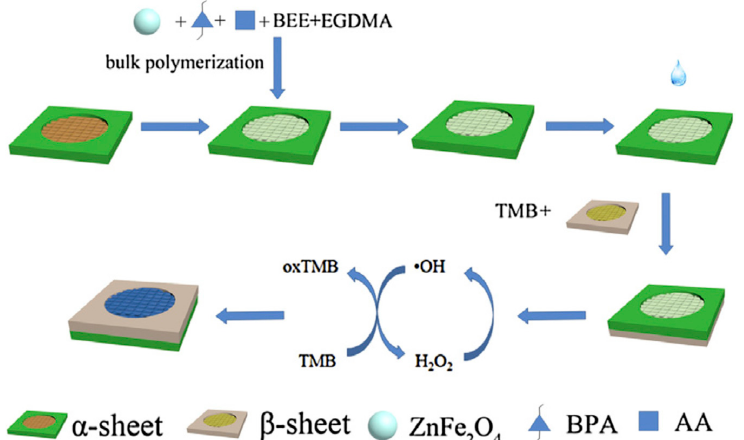
Figure 9. The paper-based colorimetric sensor fabrication steps. Republished with permission from Kong et al. [63].